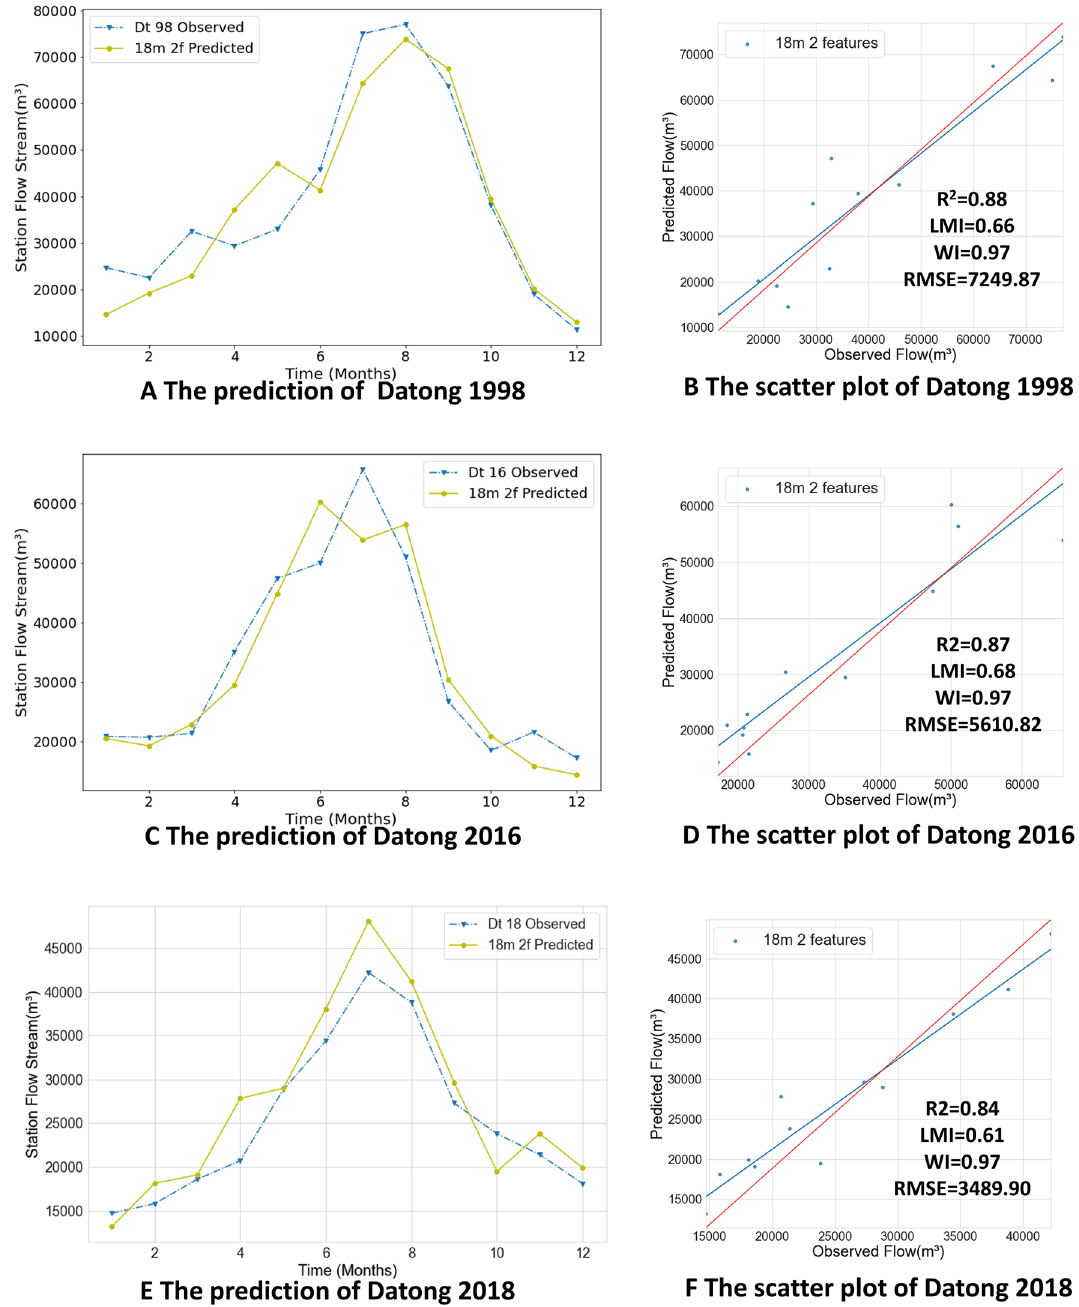
Figure 11. The result of Datong station. ( A, C, E ) Line plots of predicted and observed values. The blue dashed line represents the observed values. The green solid line are predicted values. ( B, D, F ) Scatter plots of predicted